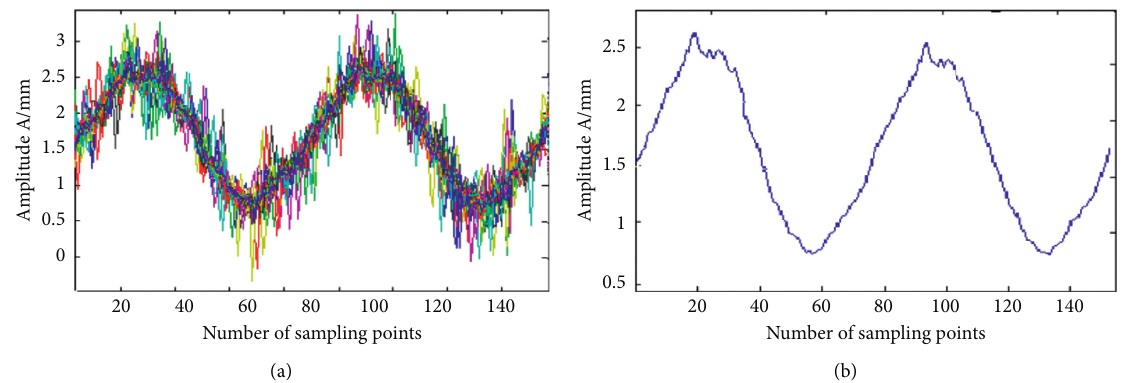
Figure 9: Improved TDA processing results. (a) Improved synchronous correction data segment and (b) stacking average